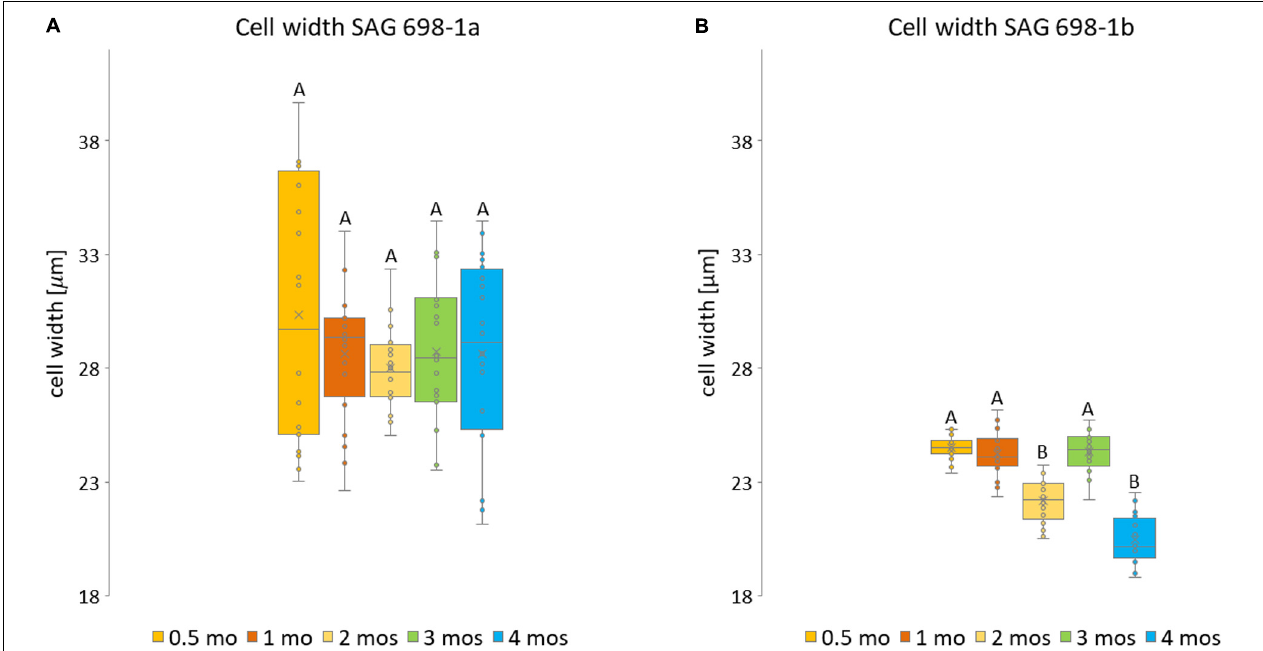
FIGURE 3 | Measurements of SAG 698-1a and SAG 698-1b according to culture age. For each culture age, 20 randomly selected cells from three biological replicates were measured of (A) SAG 698-1a and (B) SAG 698-1b. Statistically significant differences (multifactor ANOVA, p < 0.01) are indicated with different upper-case letters. The detailed info can be found in Supplementary Table 1 .